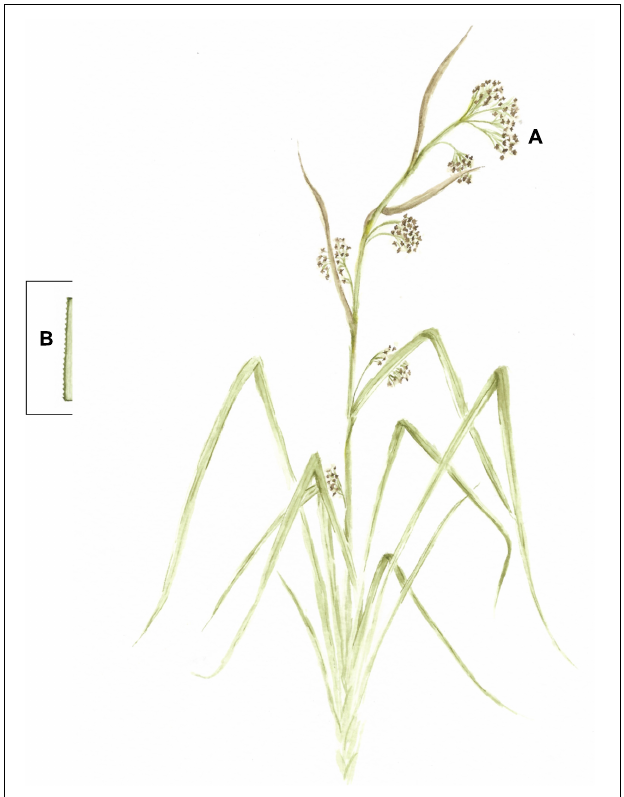
FIGURE 1 | Illustration of Cladium mariscus (L.) Pohl (sawgrass) aerial organs: inflorescences (A) and detail of leaves (B) . Illustration made by M. Oliveira.